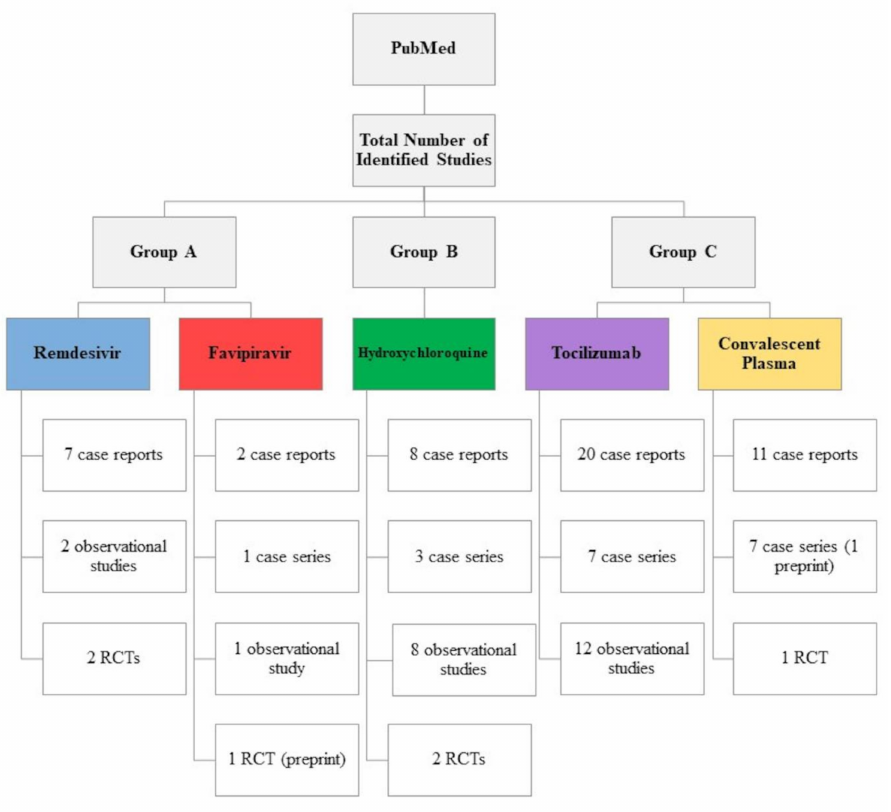
Figure 1. Number of studies retrieved for remdesivir, favipiravir, hydroxychloroquine, tocilizumab, and convalescent plasma in coronavirus disease 2019 (COVID-19) patients as of 1 October 2020. RCT: randomized controlled